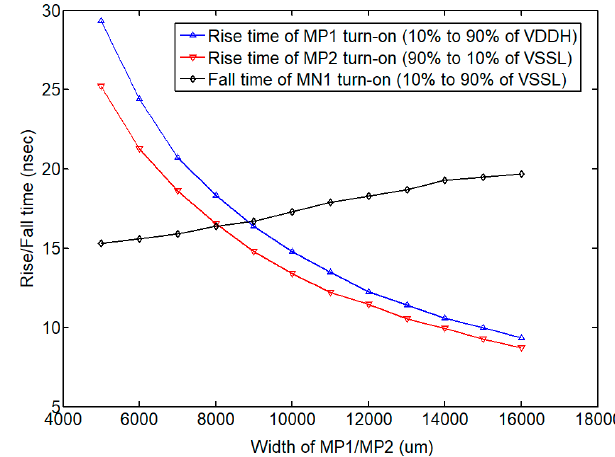
Figure 15. Package / chip joint design with parasitic parameter extractions. Figure 15. Package/chip joint design with parasitic parameter extractions. Figure 15. Package/chip joint design with parasitic parameter extractions.